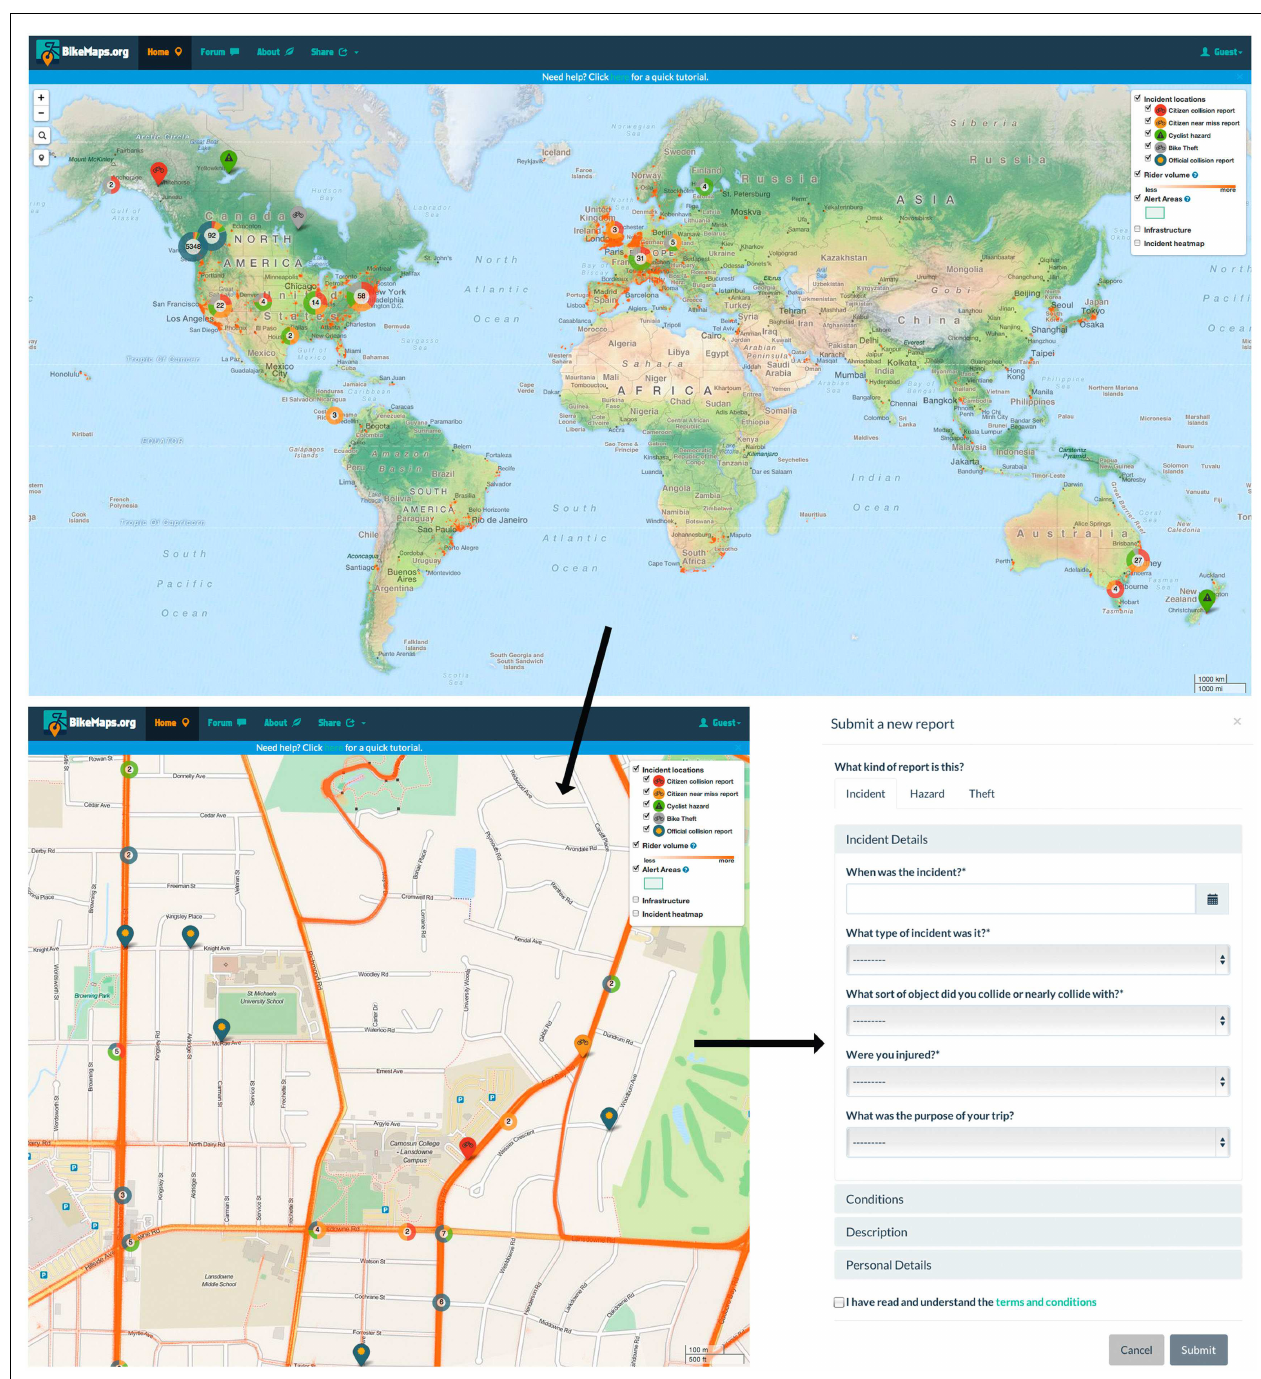
the view typically used by the citizen mapper when adding data.The lower – right is an example of the table used to collect attribute data on each cycling